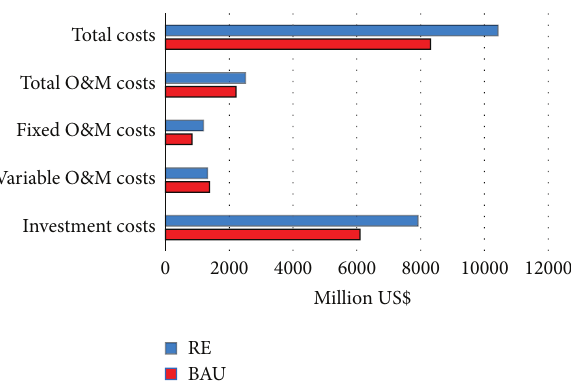
Figure 6: BAU and RE scenarios costs